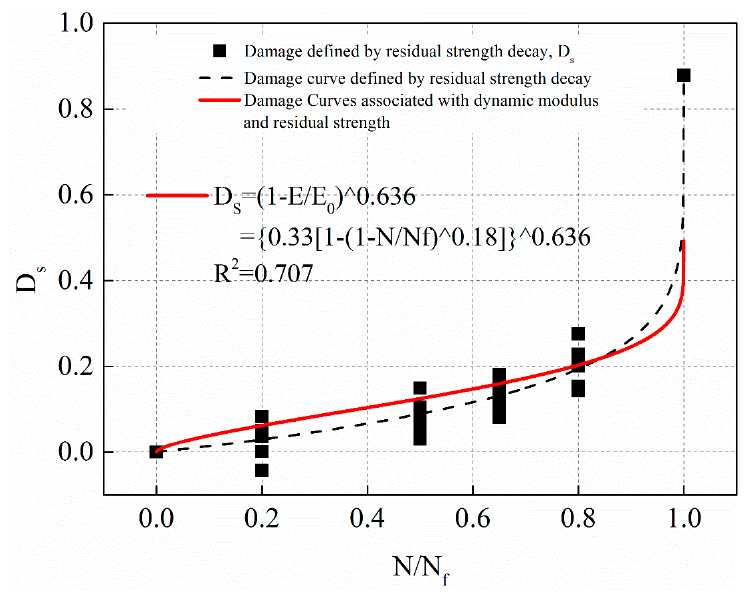
Figure 24. The damage evolution curve associated with dynamic modulus and residual strength with stress levels of 0.5 MPa.